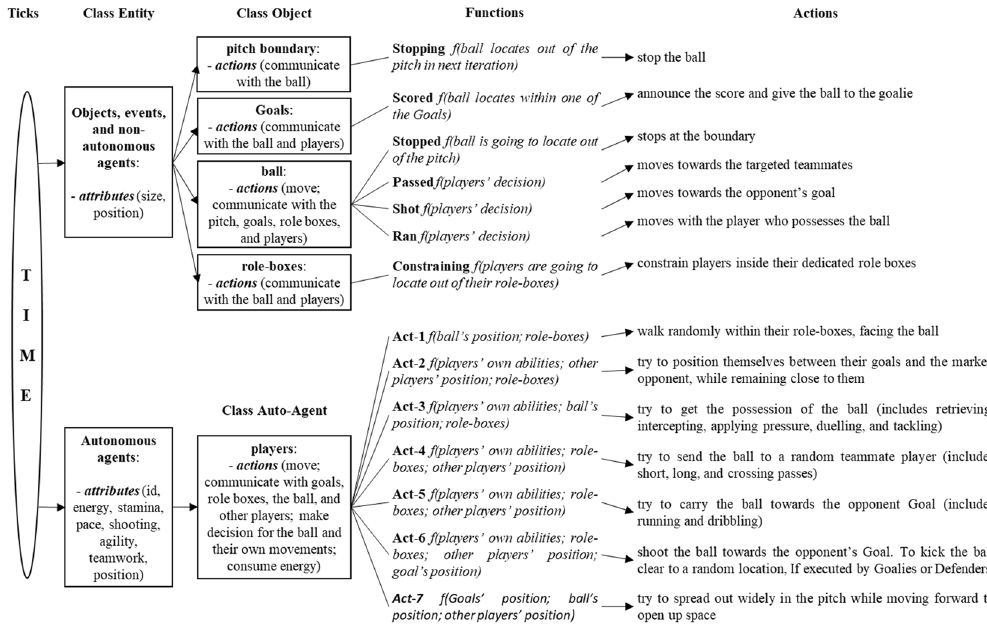
Figure 2. The structure of the model. Adapted with permission from S.C. Ahearn, J.L.D. Smith, A.R. Joshi and J. Ding, Ecological Modelling; Elsevier, 2001.